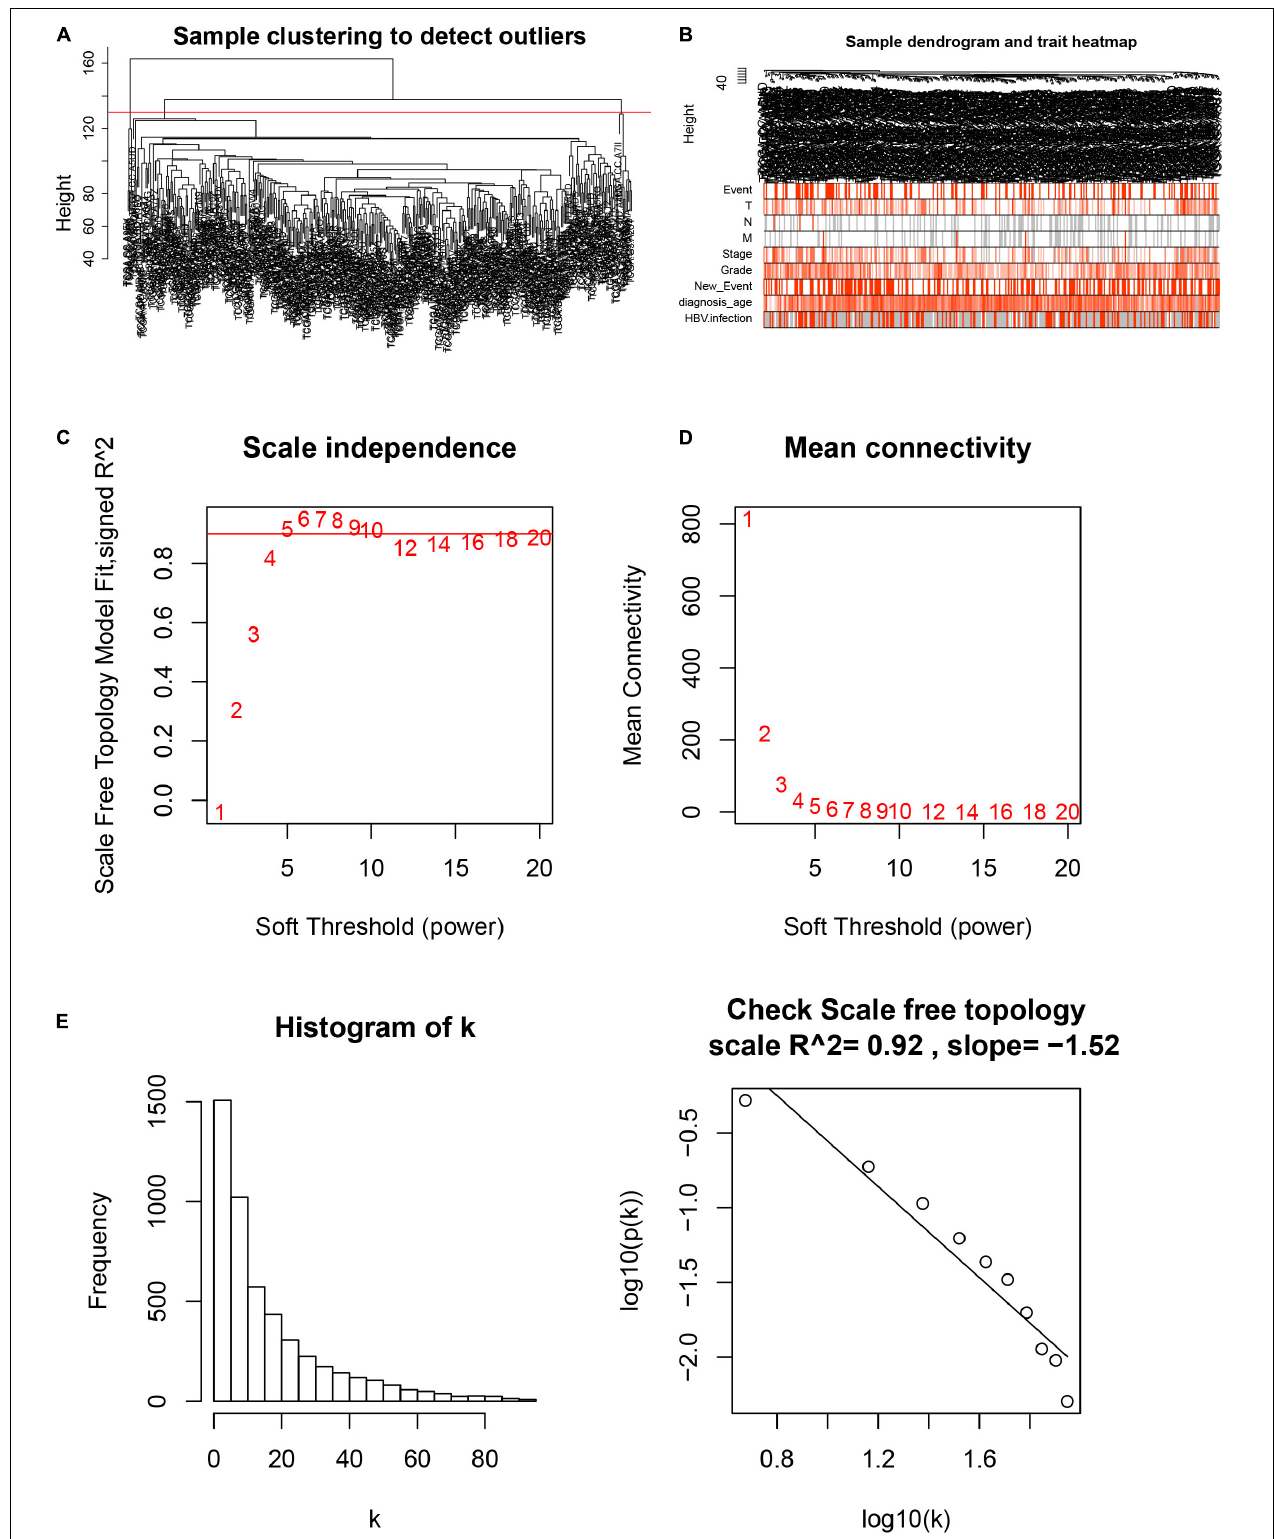
FIGURE 4 | Sample clustering and determination of thresholding power in weighted gene co-expression network analysis (WGCNA). (A) Sample clustering to detect outliers. (B) Sample dendrogram and trait heatmap. (C) Analysis of the scale-free fit index for various soft-thresholding powers ( β ). (D) Analysis of the mean connectivity for various soft-thresholding powers. (E) Checking the scale-free topology when β = 5.